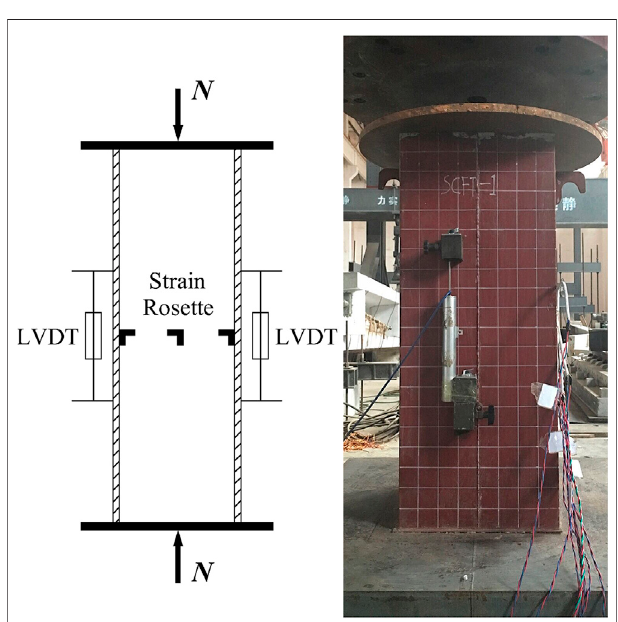
FIGURE 1 | Experimental instrumentation for all